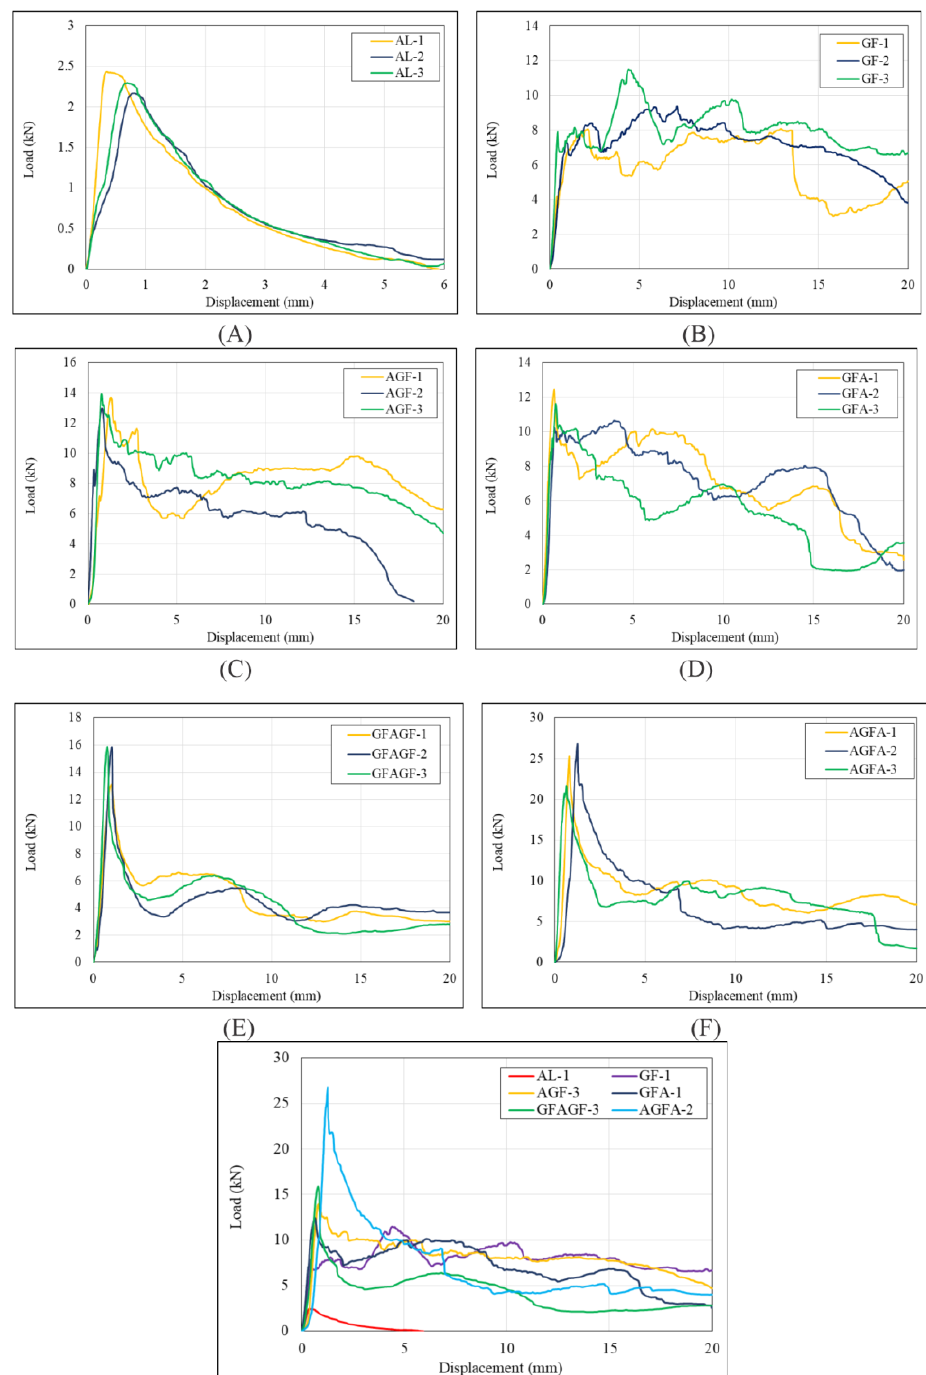
Figure 8. Axial crashworthiness indicators of each specimen load and displacement curve of ( a ) peak crushing force (PCF), ( b ) F average, ( c ) energy absorption (EA), ( d ) specific energy absorption (SEA), ( e ) crush force efficiency (CFE).